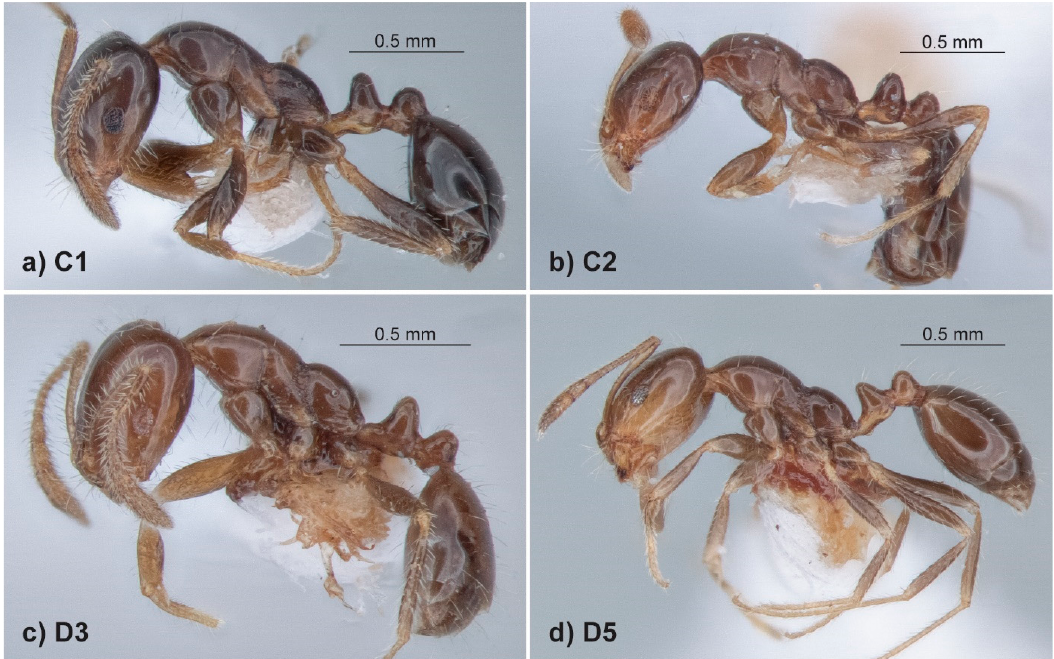
Figure 5. Images of species from the ‘ donisthorpei ’ morphotype. ( a ) Specimen OZBOL4021-16; Hayfield Shenandoah Stn; NT; ( b ) specimen OZBOL4451-21; Gove Peninsula, NT; ( c ) specimen MONO257-16; Mitchell Falls, WA; ( d ) specimen 318 from Andersen et al. 2013.